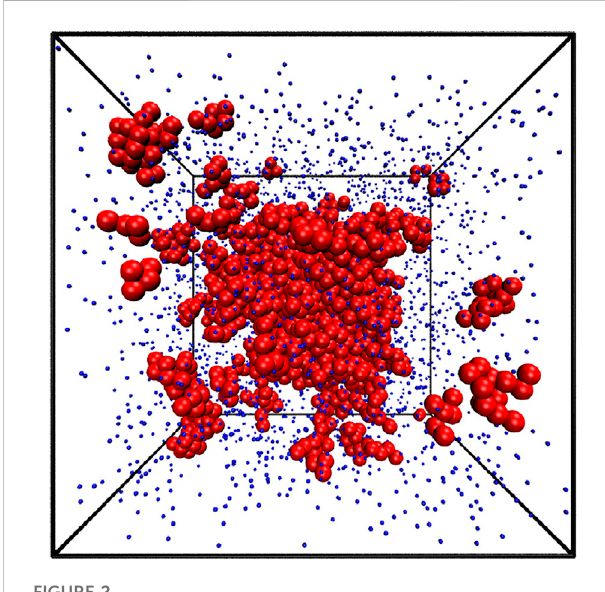
FIGURE 2 The snapshot of the equilibrium state from the simulation at ρ *=0.1 and T *=1.1. The largest cluster contains 1160 atoms and is shown at the very center. 14 smaller clusters are also highlighted. They contain between 9 and 15 atoms. FIGURE 3